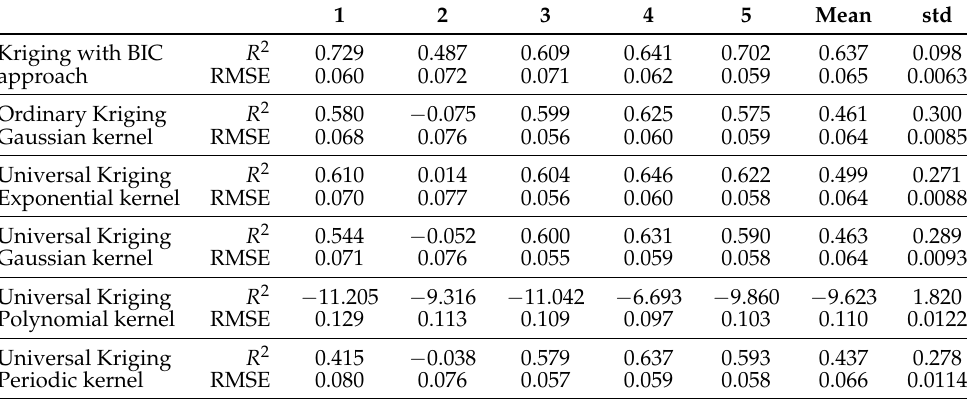
Table 3. Performance evaluation of selected models. Results of cross-validation of the obtained models on 5 different train/test